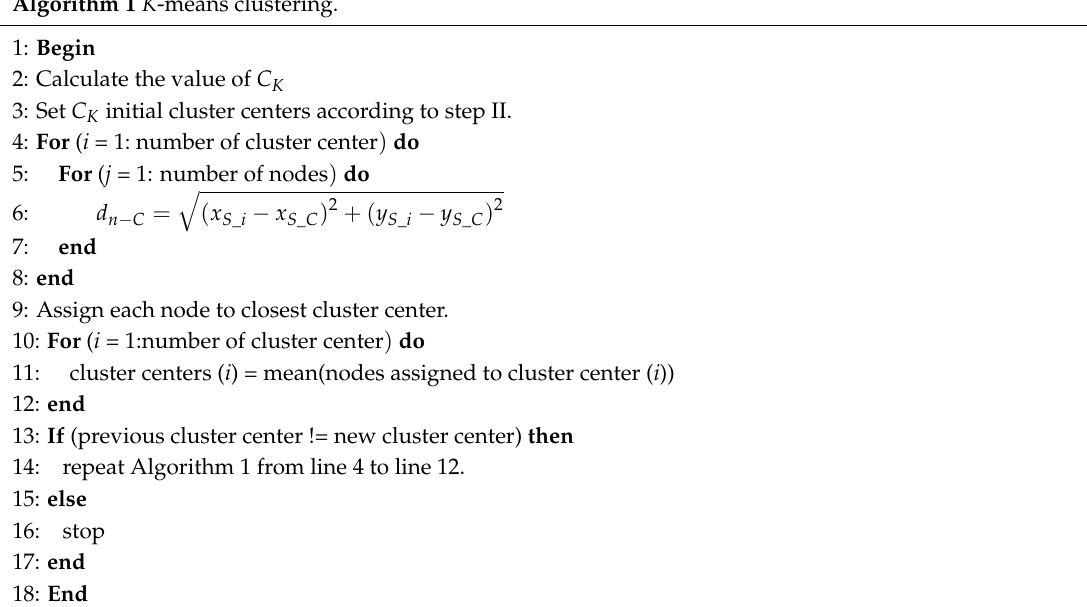
Algorithm 1 K -means